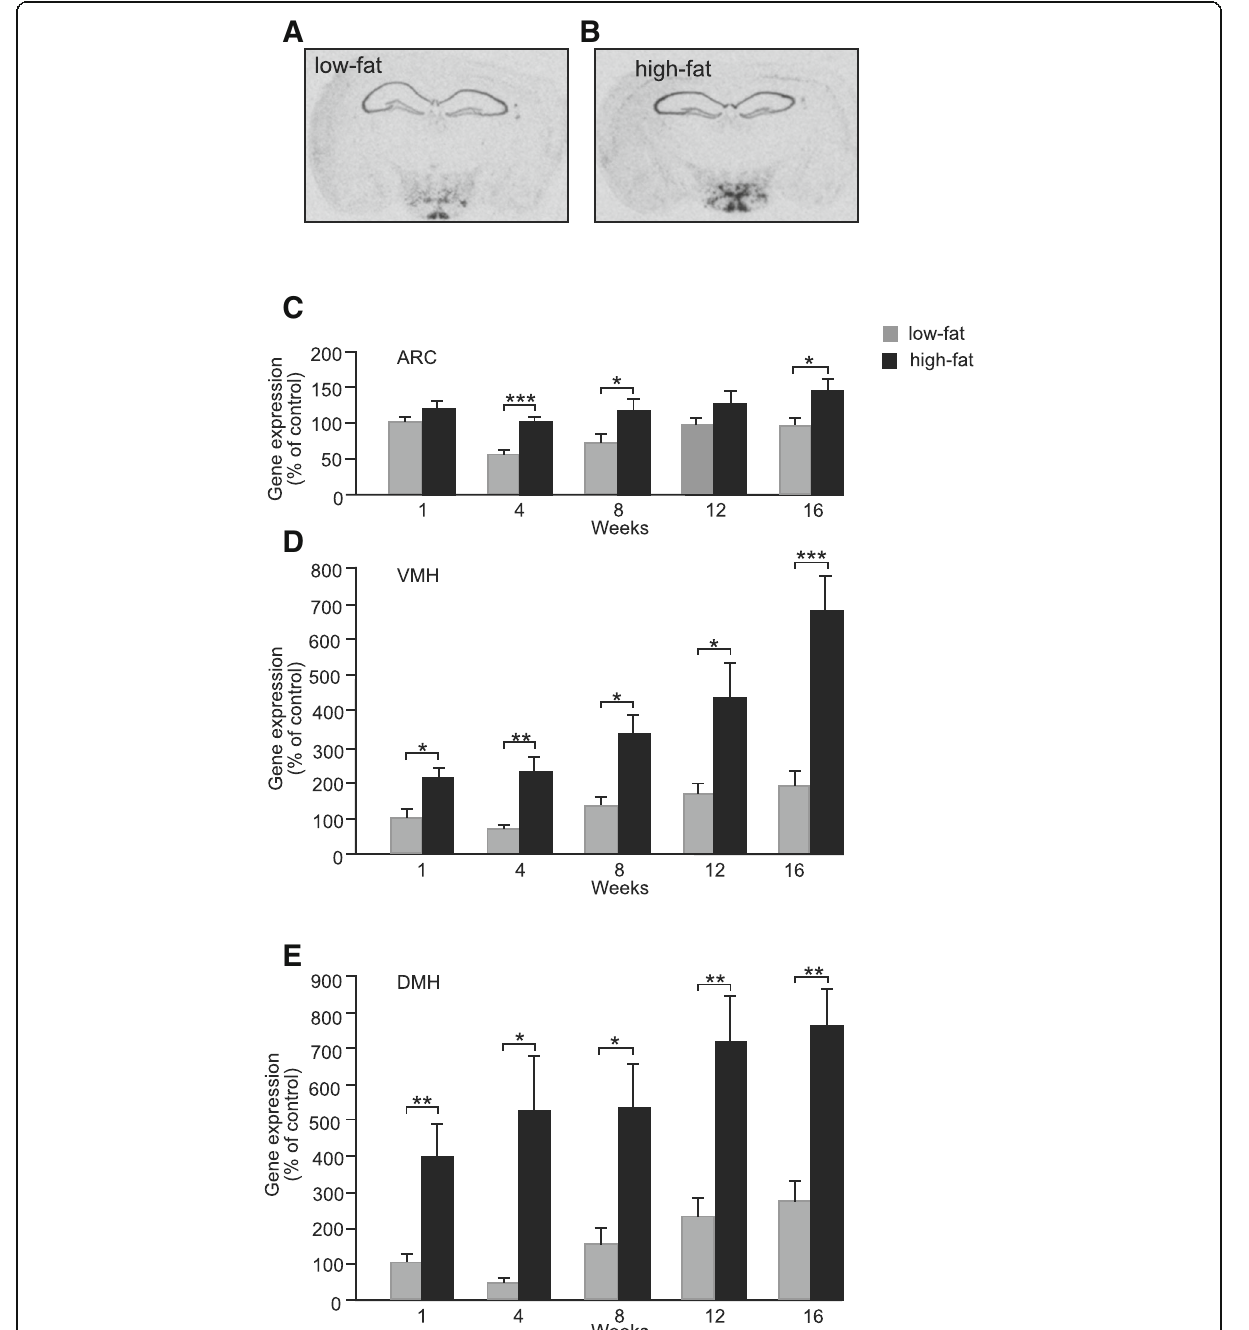
Fig. 3 Representative in situ autoradiographs of C57BL/6J mouse brain sections showing serpinA3N expression in a LFD-fed mouse and b HFD- fed mouse. Levels of serpinA3N gene expression in LFD- and HFD-fed mice measured by semi-quantitative in situ hybridisation c in the arcuate nuclei (ARC), d the ventromedial nuclei of the hypothalamus (VMH) and e the dorsomedial nuclei of the hypothalamus (DMH). Two-way ANOVA showed a significant effect of diet P < 0.001 for the ARC, VMH and DMH and time P < 0.001 for the VMH and P < 0.05 for the ARC and DMH with an interaction between diet and time P < 0.05 for the VMH only. One-way ANOVA showed differences between HFD and LFD from 4 weeks onwards for the ARC and for all times tested for the VMH and DMH. * P < 0.05, ** P < 0.01, *** P < 0.001 ( n =